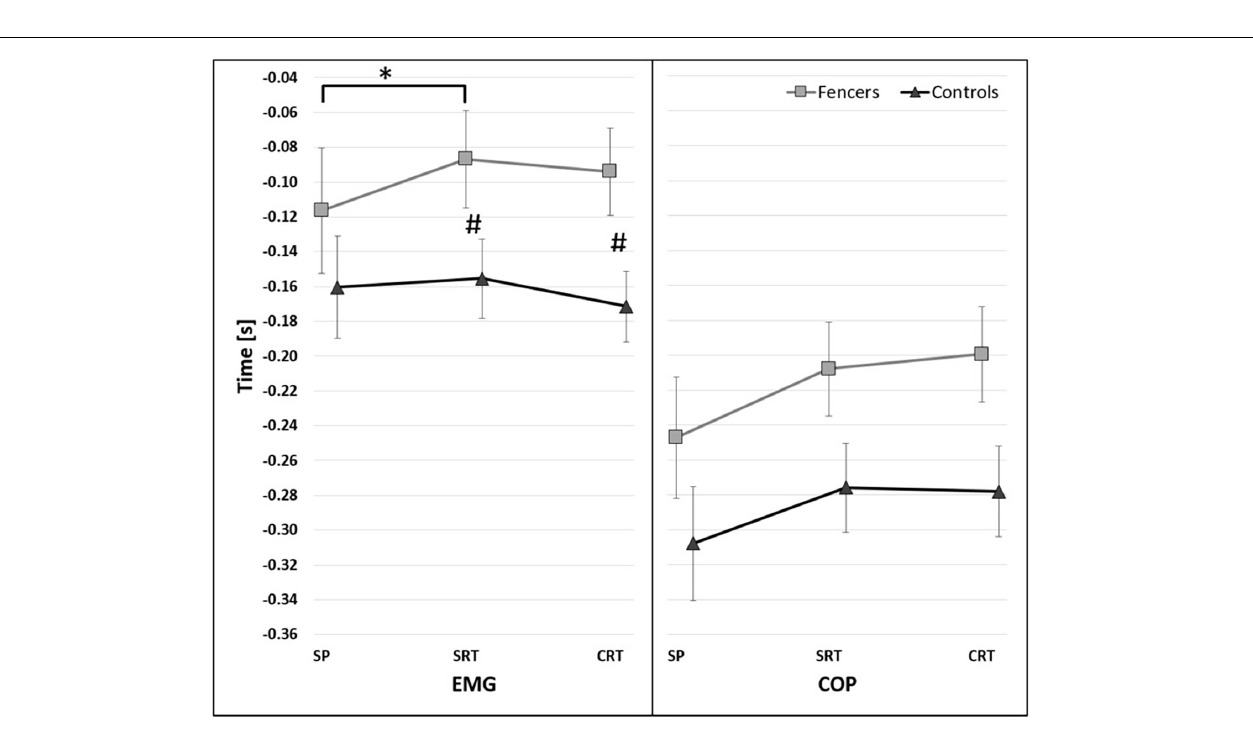
FIGURE 5 | The average time of the onset of TA activity (EMG) and COP displacement (COP) before t 0 for interaction between reaction and group factors. The significant differences between groups were marked as #. The significant differences between reaction time conditions were marked as * (95% confidence interval presented as error